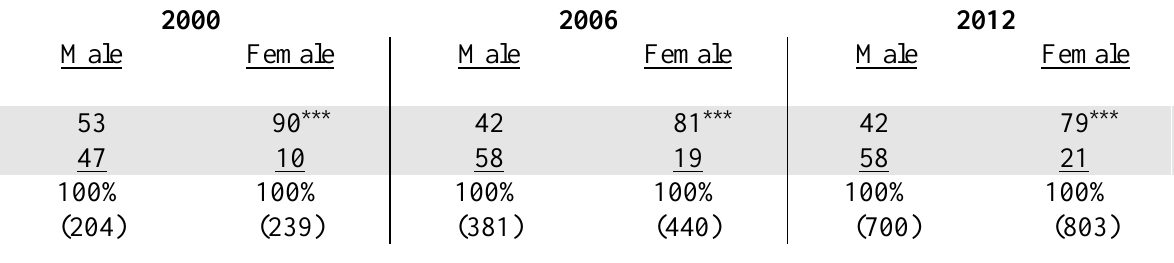
Table 32. Views of Respondents About Increasing the Proportion of Women Senior